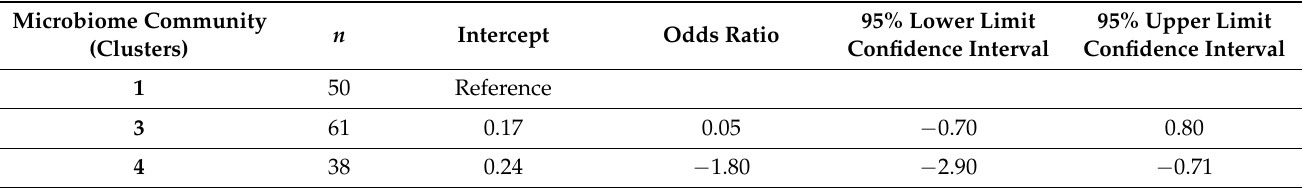
Table 7. Multinomial logistic regression evaluating the association between microbiome community and low pasture